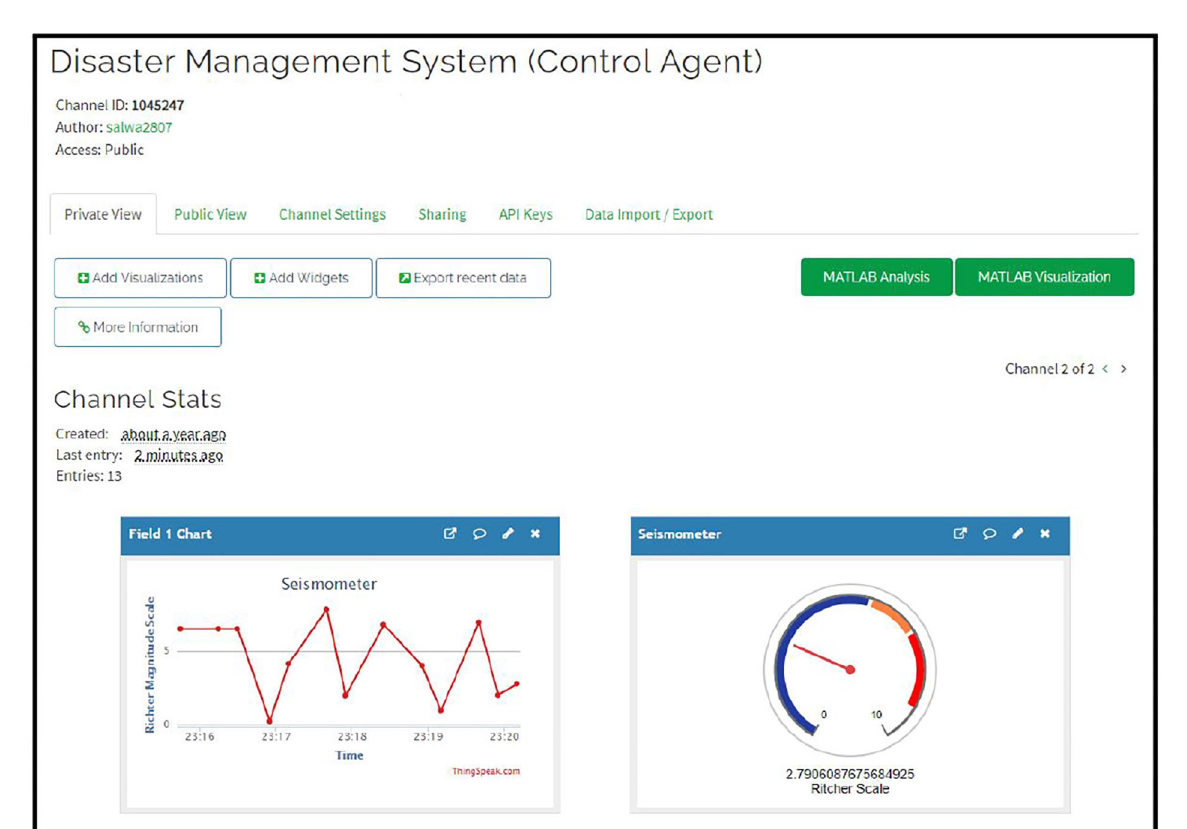
FIGURE8 The data sent by some of the different agents developed for the proposed system.